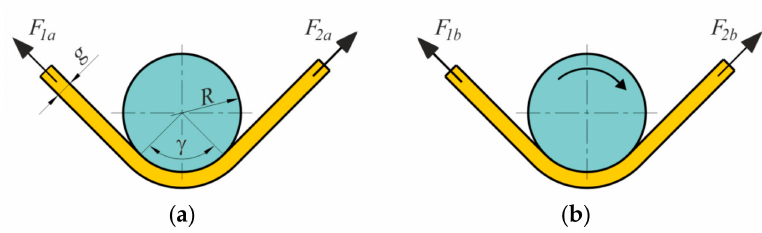
Figure19. Schematicdiagramofthebendingundertensiontestrealizedby( a )fixedand( b